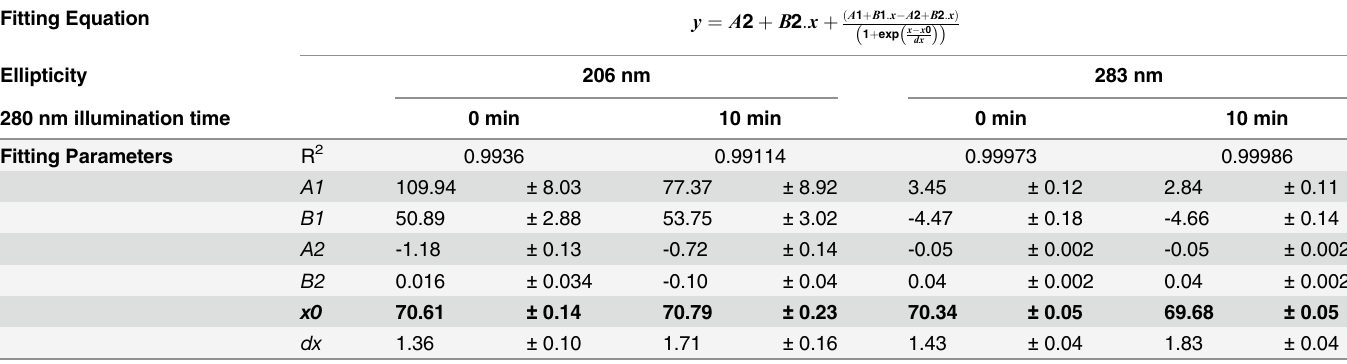
Table 7. Parameter values obtained upon fi tting the circular dichroism thermal unfolding curves (ellipticity at 206 nm, Fig. 12A; ellipticity at 283 nm, Fig. 12B) of human plasminogen with a modi fi ed Boltzmann function. Fitting